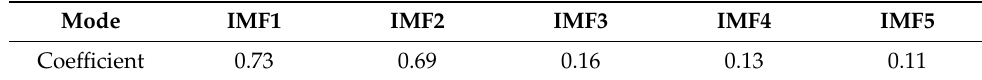
Table 2. Coefficients under IEMD decomposition.